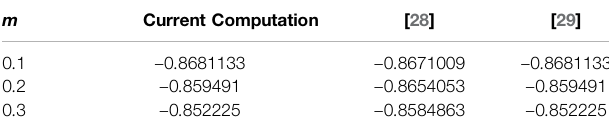
TABLE 3 | Comparison for F ″ ( η (cid:2) 0 ) with existing